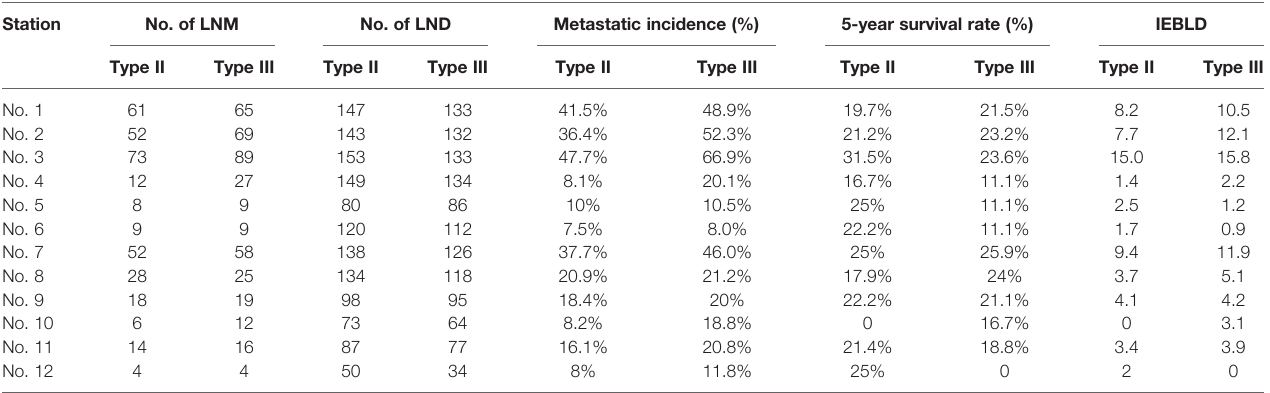
TABLE 3 | Therapeutic value index of each lymph node station in Siewert type II/III patients. Station No. of LNM